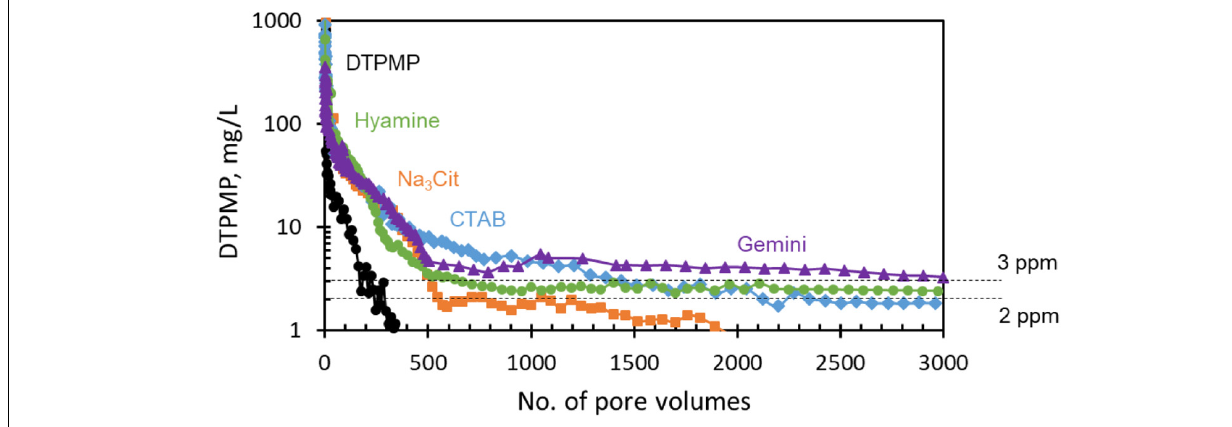
FIGURE 8 | DTPMP return concentrations in laboratory column squeeze test.